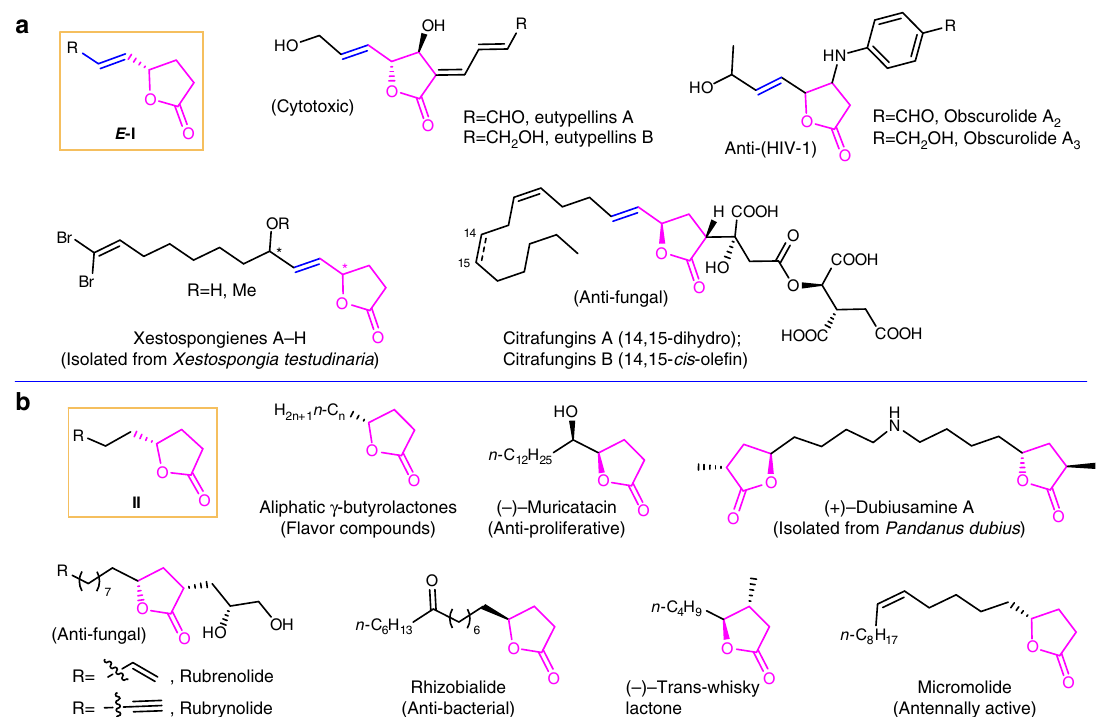
Fig. 1 Representative examples of γ -( E )-vinylic and γ -alkylic- γ -butyrolactones. a Common structure unit and representative examples of γ -( E )-vinylic γ - butyrolactones ( E- I ); b Common structure unit and representative examples of γ -alkylic γ -butyrolactones ( II